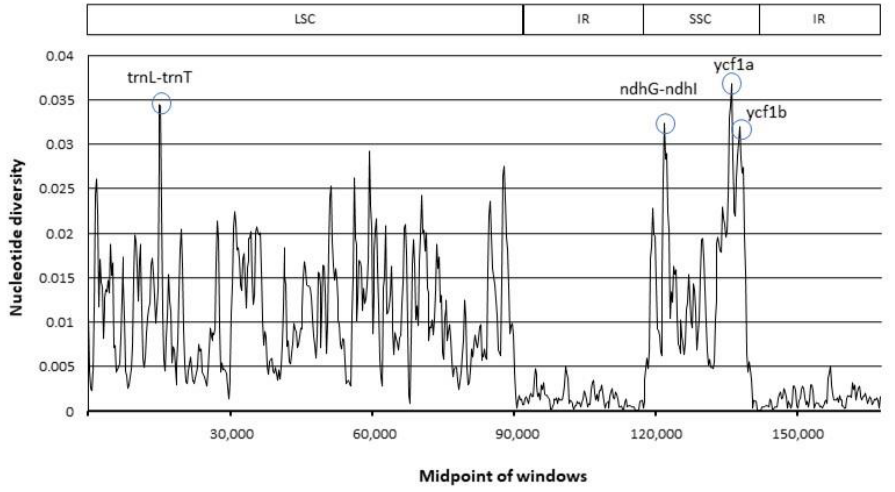
Figure 3. Comparison of the junction regions of the cp genomes of the five Dalbergia species. (JLB: junction between LSC and IRB; JSB: junction between SSC and IRB; JSA: junction between SSC and IRA; JLA: junction between LSC and IRA).